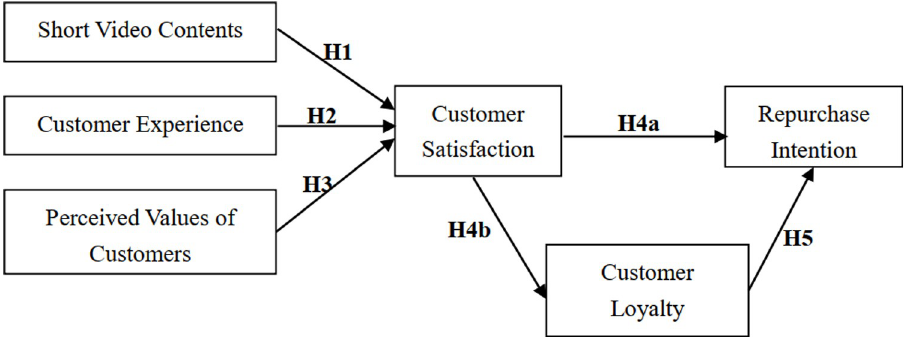
Fig 1. Influencing factors of the repurchase intention on short video